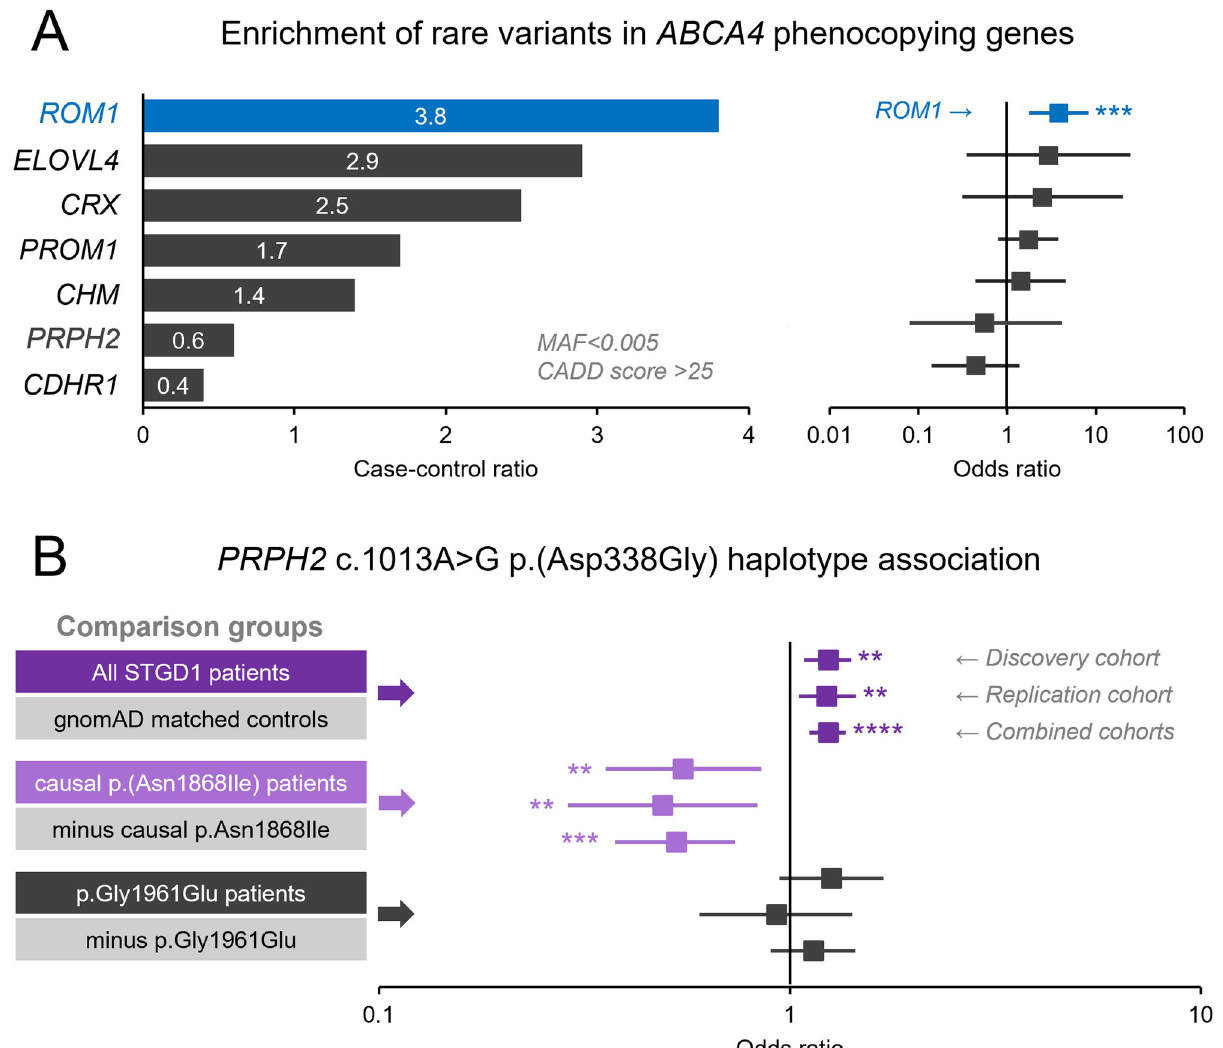
Fig 2. Case-control analysis of rare and common variants of seven macular dystrophy genes in the Stargardt/ABCA4 disease. (A) Moderately rare variants in ROM1 with a minor allele frequency (MAF) < 0.005 and CADD (v1.3) score > 25 were significantly enriched in the discovery cohort compared to a matched control cohort by a factor of 3.8 (horizontal blue bar). The case-control ratio is the percentage of cases harboring qualified variants among the ABCA4 disease cohort (n = 622) divided by the percentage of cases harboring qualified variants matched controls (n = 10,865). (B) Forest plot of odds ratios with 95% confidence intervals (whiskers) of variant enrichment between patients and controls. OR > 1 signifies enrichment in ABCA4 disease. (B) The minor c.1013A-tagged haplotype in the C-terminal end of PRPH2 was significantly elevated across all patients in the discovery, replication, and combined cohorts compared to matched general population frequencies reported in gnomAD. Analysis of genetically determined clinical subgroups suggested a significant reduction of the same haplotype in patients harboring the hypomorphic p.Asn1868Ile allele. For significance level, two asterisks ( �� ) denotes P � 0.01, three asterisks ( ��� ) denotes P � 0.001. and four asterisks ( ���� ) denotes P �